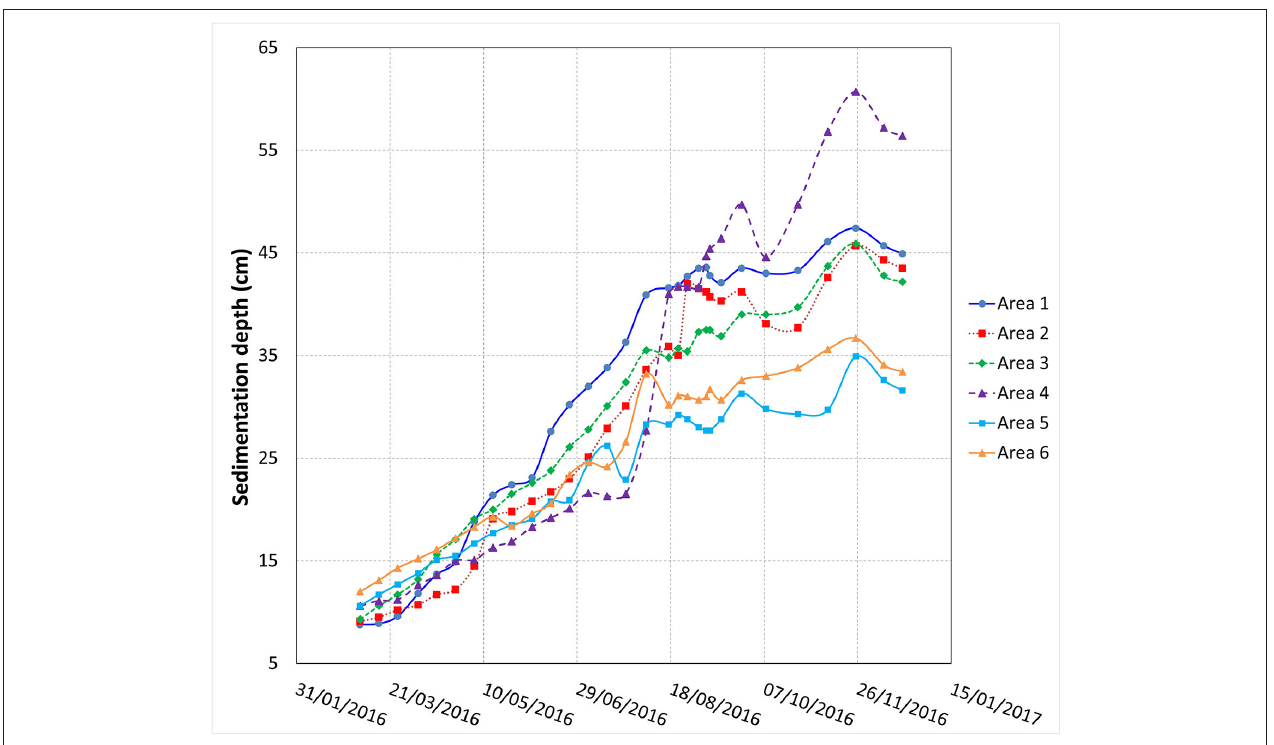
FIGURE 9 | Sediment accumulation in the study area after the presence of bamboo